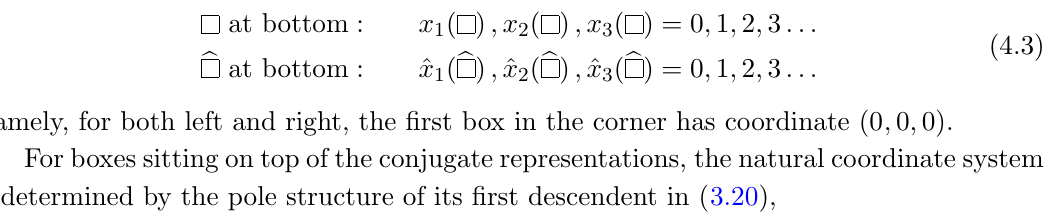
(cid:4) in terms of twin plane j i